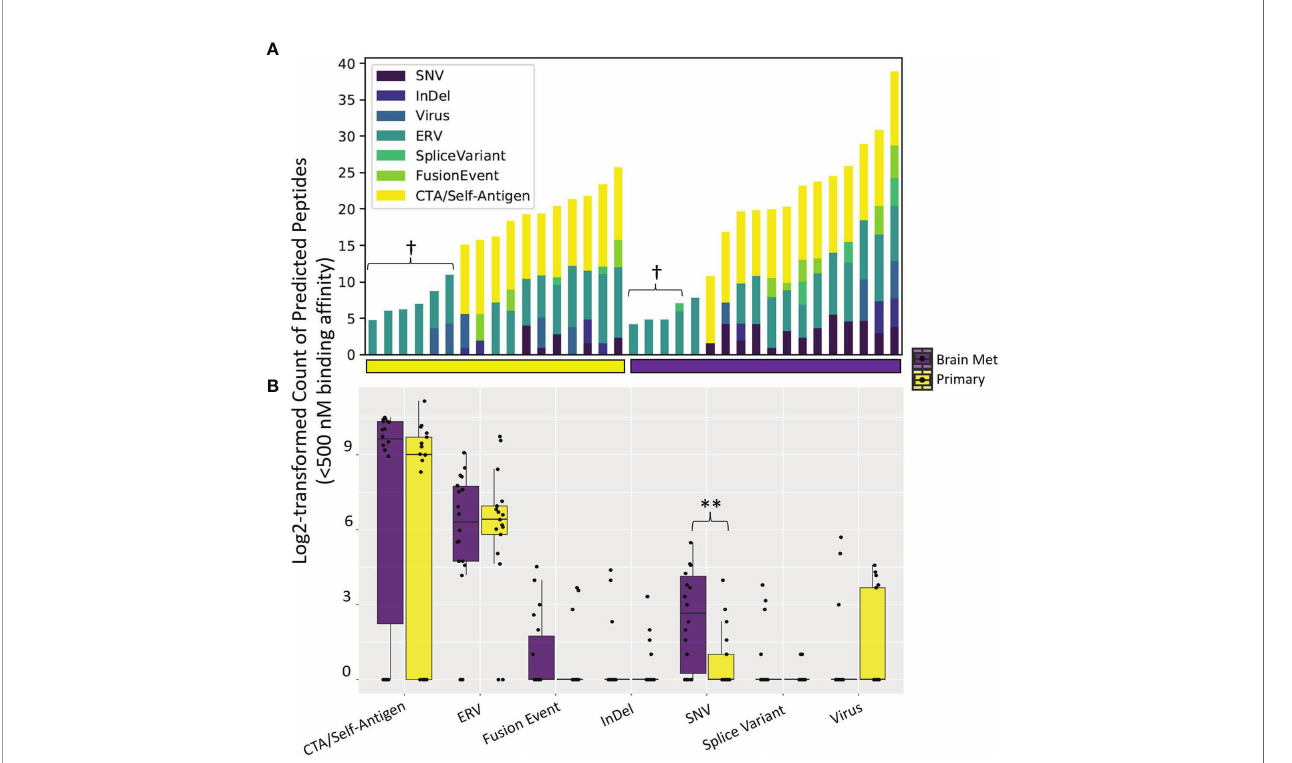
FIGURE 2 | Tumor antigen sources among the LCCC1419 patients. A comprehensive bioinformatics prediction pipeline that exports (A) the number of neoantigen- derived MHC class I-binding peptides (Kd < 500 nM) broken down by antigen source was employed. Some patients ’ tumors did not have associated tumor or normal whole-exome sequencing data, and as such, antigen sources that require DNA sequencing data (single-nucleotide variants, InDels, cancer testis antigens, or fusion events) are not able to be queried in these cases (denoted by † ). (B) Distribution of the number of neoantigen-derived MHC class I-binding peptides (Kd < 500 nM) broken down by antigen source, corresponding to (A) ; ** p < 0.01 (Wilcoxon rank-sum test).